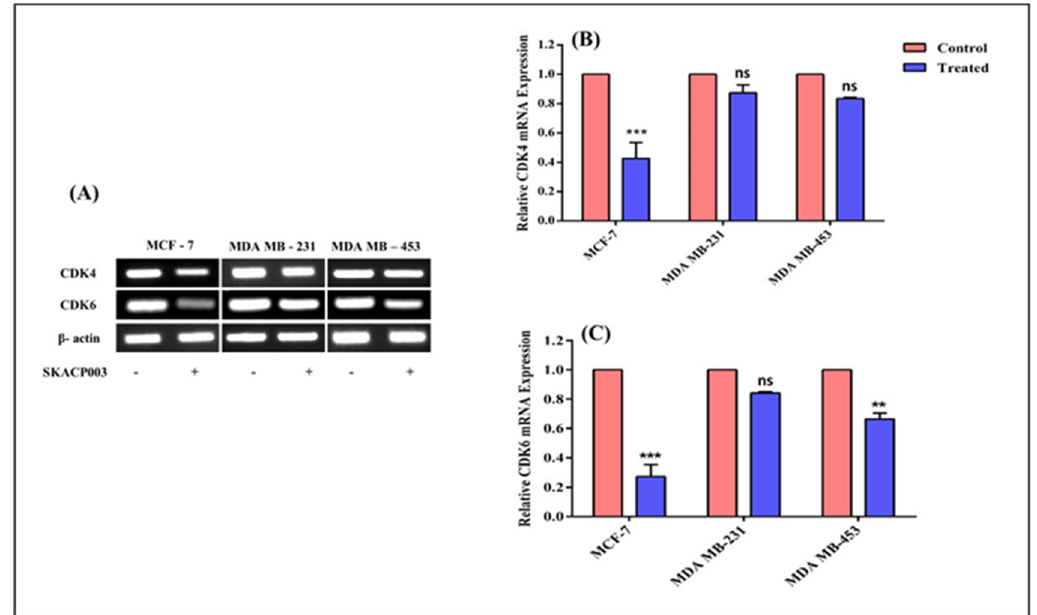
Figure 2. Down-regulation of CDK-4 and CDK-6 expressions by SKACP003 in breast cancer cell lines. The mRNA levels of CDK-4 and CDK-6 from total RNA were analyzed by RT-PCR for the control and SKACP003-treated breast cancer cell lines of MCF-7, MDA-MB-231, and MDA-MB-453. ( A ) RT-PCR products; ( B ) downregulation of CDK-4 by SKACP003; ( C ) downregulation of CDK-6 by SKACP003. ** = statistical significance at p < 0.01; *** = statistical significance at p < 0.001; ns = not significant.